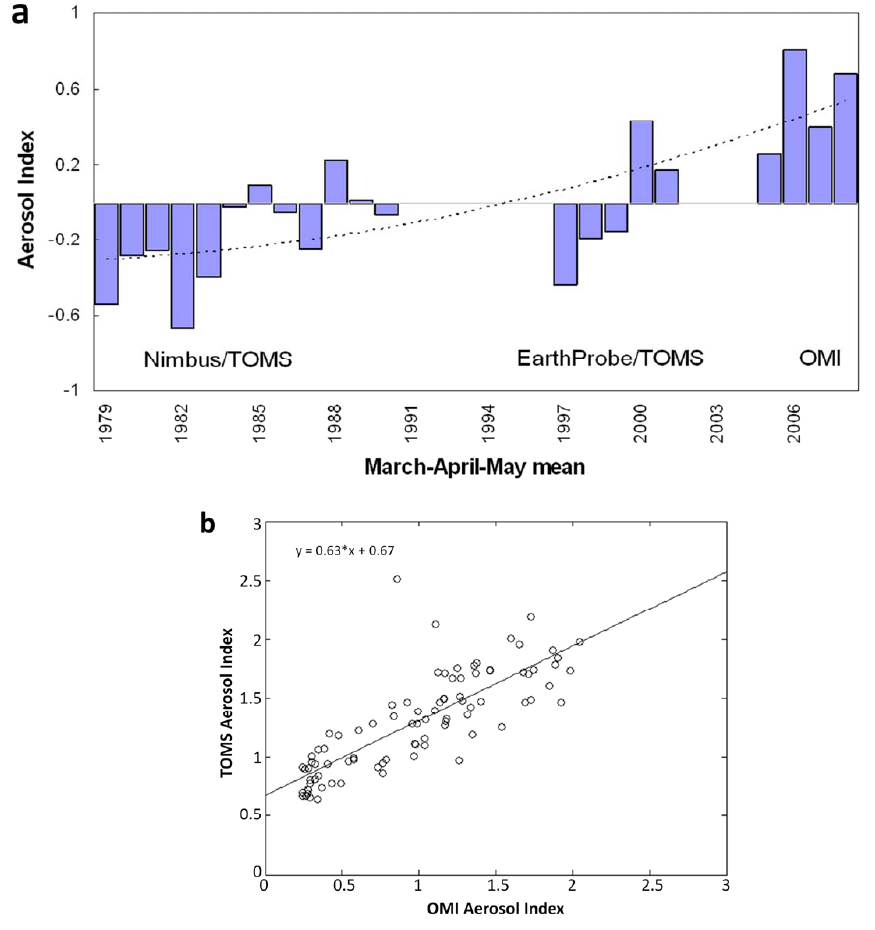
Figure 5 Fig. 5. (a) Inter-annual variations of pre-monsoon Absorbing Aerosol Index from Nimbus 7/TOMS (1979–1992), EarthProbe/TOMS